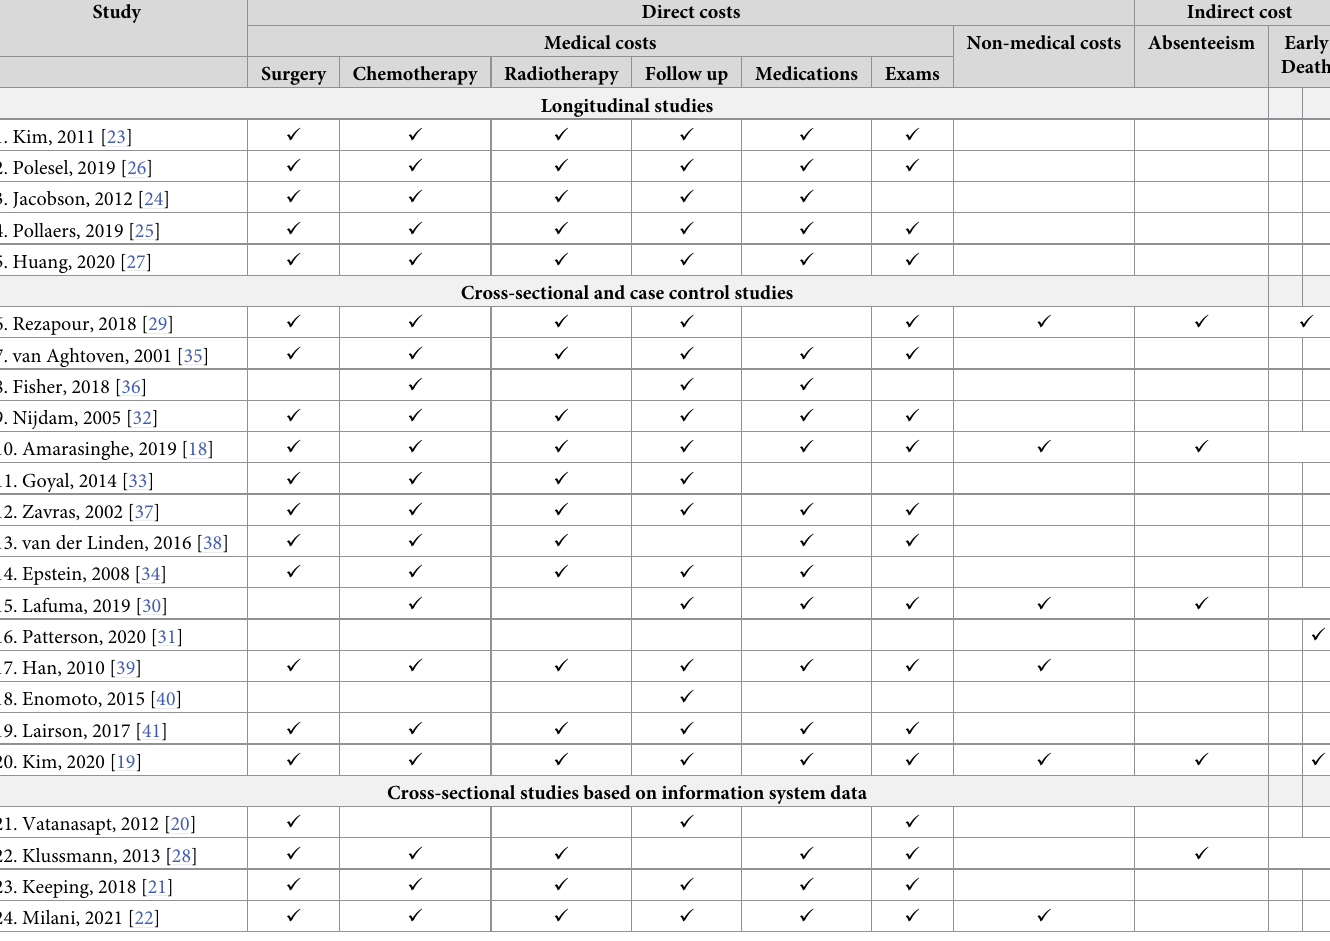
Table 4. Estimates of medical, non-medical, and indirect costs of oral cancer presented in the methods of studies from 2001 to 2020.